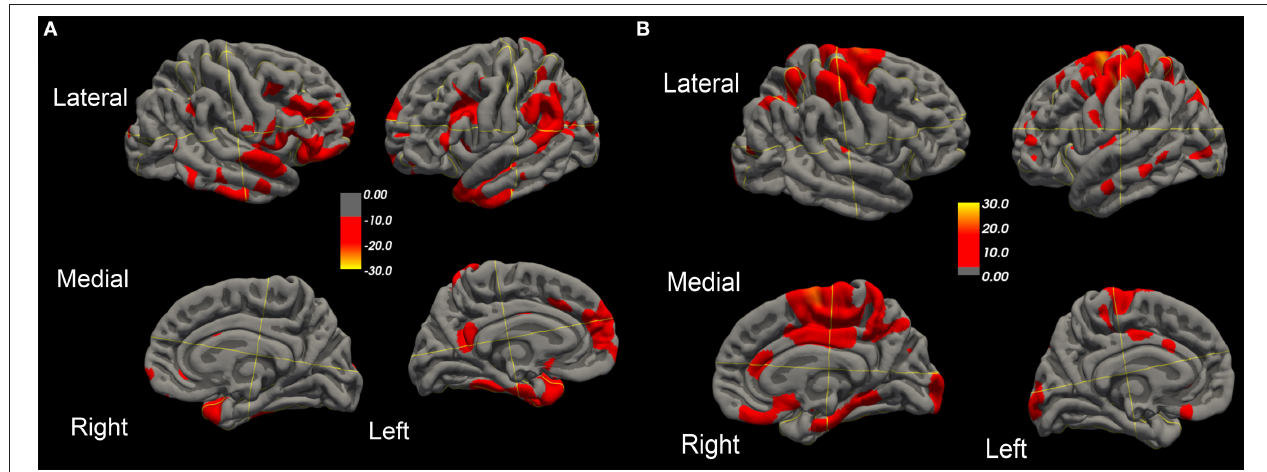
FIGURE 2 | Surface-rendered MRI of right and left hemispheres show symmetrized percent change (SPC) values of cortical thickness decrease (cortical thinning) (A) or increase (cortical thickening) (B) in the ALS-FTD patient over 20.4 months.